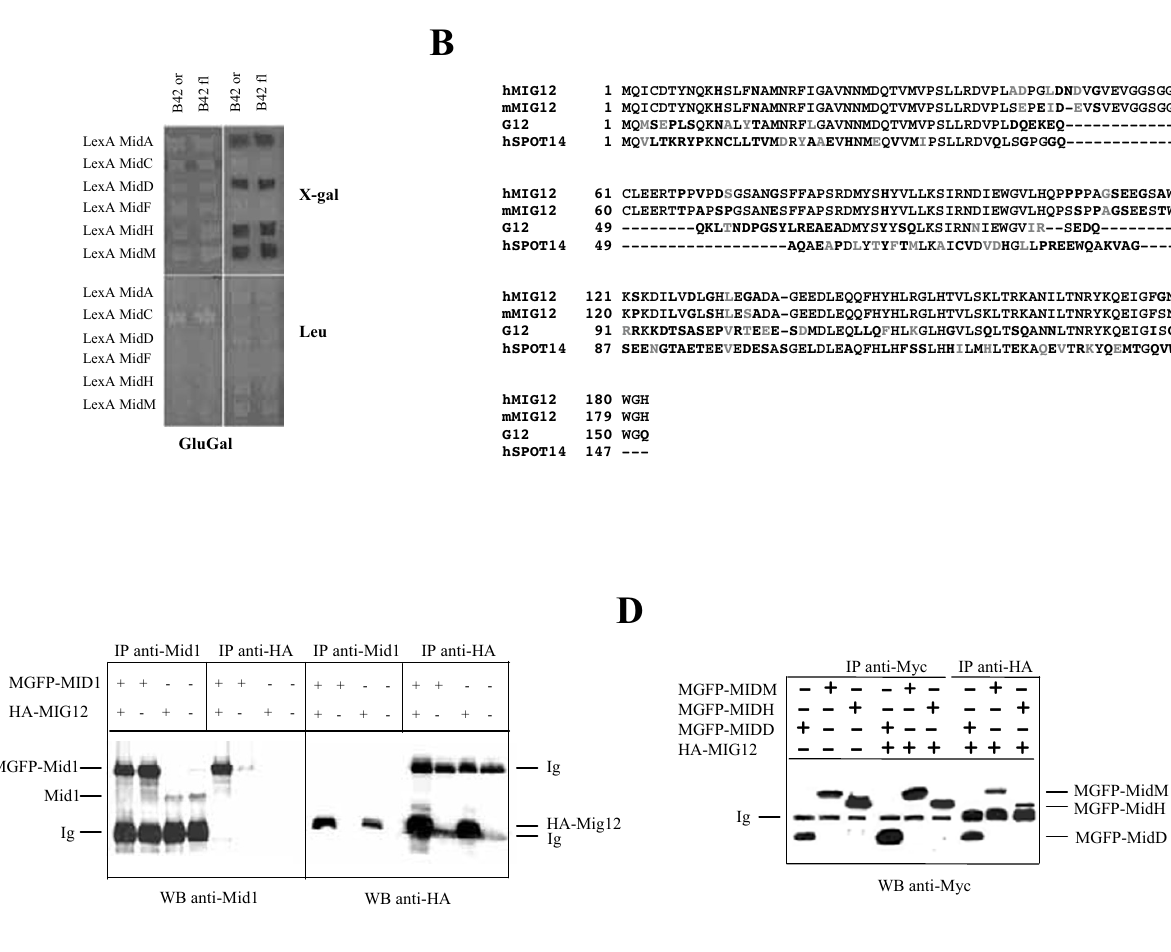
(page number not for citation purposes)